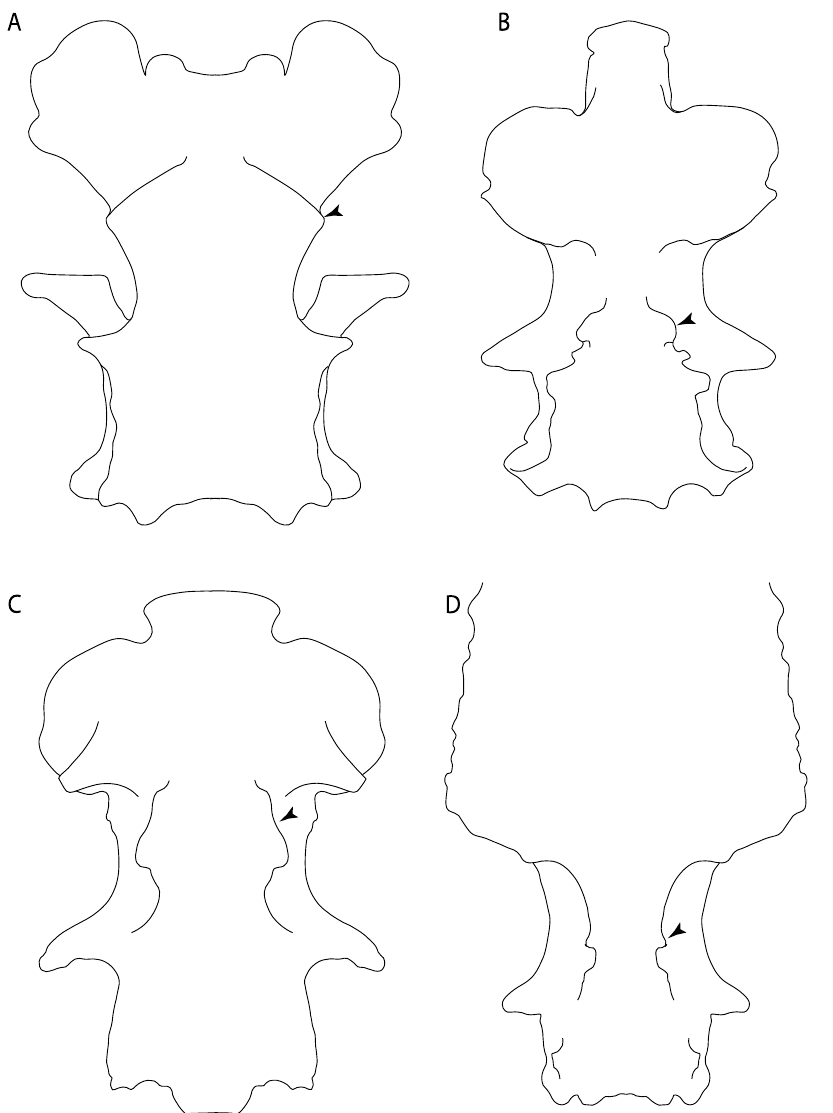
Figure 20. Interpretative drawings of the neurocranium in ventral view. State (1): ( A ) Squatina japonica (HUMZ 91670) redrawn and modified from Shirai plate 13A in [35]; ( B ) Squalus acanthias (GMBL 7313, https://sharksrays.org/ (accessed on 14 April 2020)); ( C ) Chlamydoselachus anguineus (MSM-88-40) redrawn and modified from Shirai plate 1B in [35]; ( D ) Pristiophorus nudipinnis (CSIRO 3731, https://sharksrays.org// (accessed on 14 April 2020)). Arrowhead: basitrabecular process.